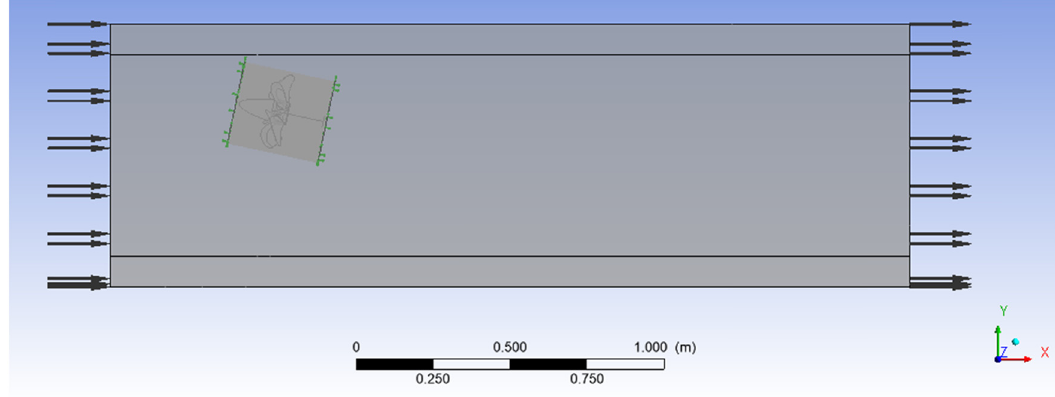
Figure 10: Design of computational domain.